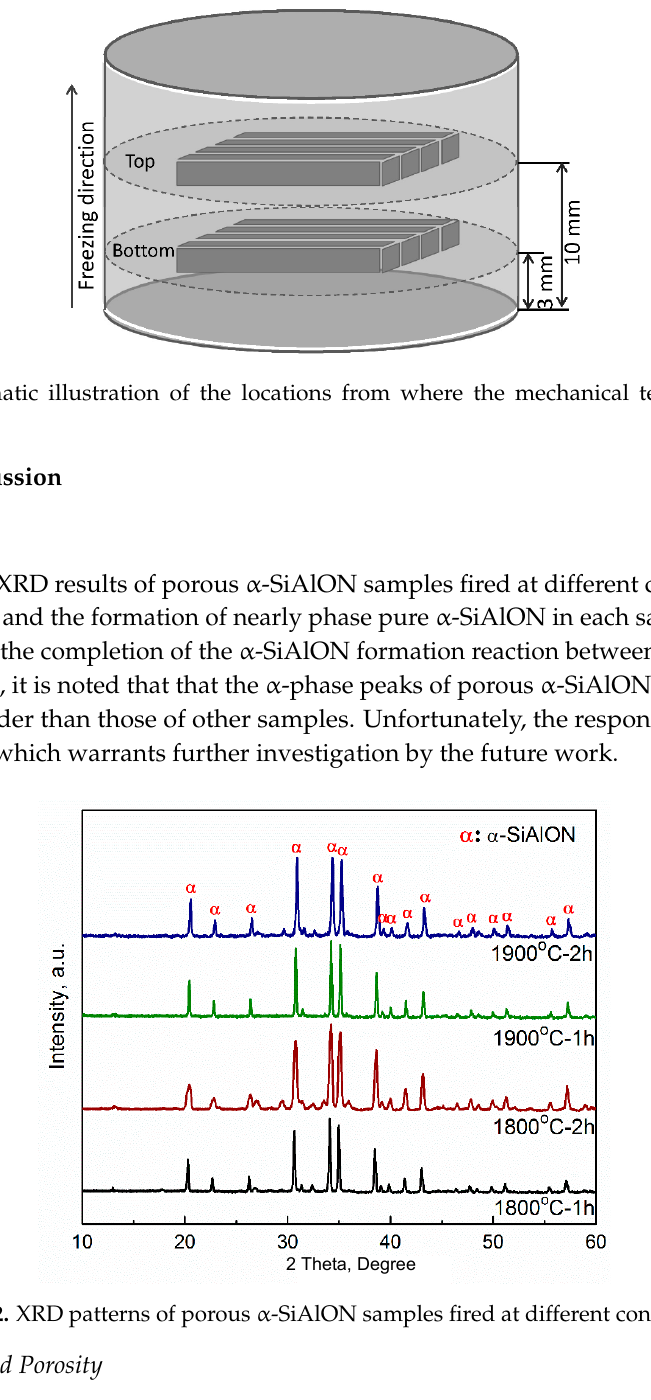
Figure 2. XRD patterns of porous α -SiAlON samples fired at different conditions.